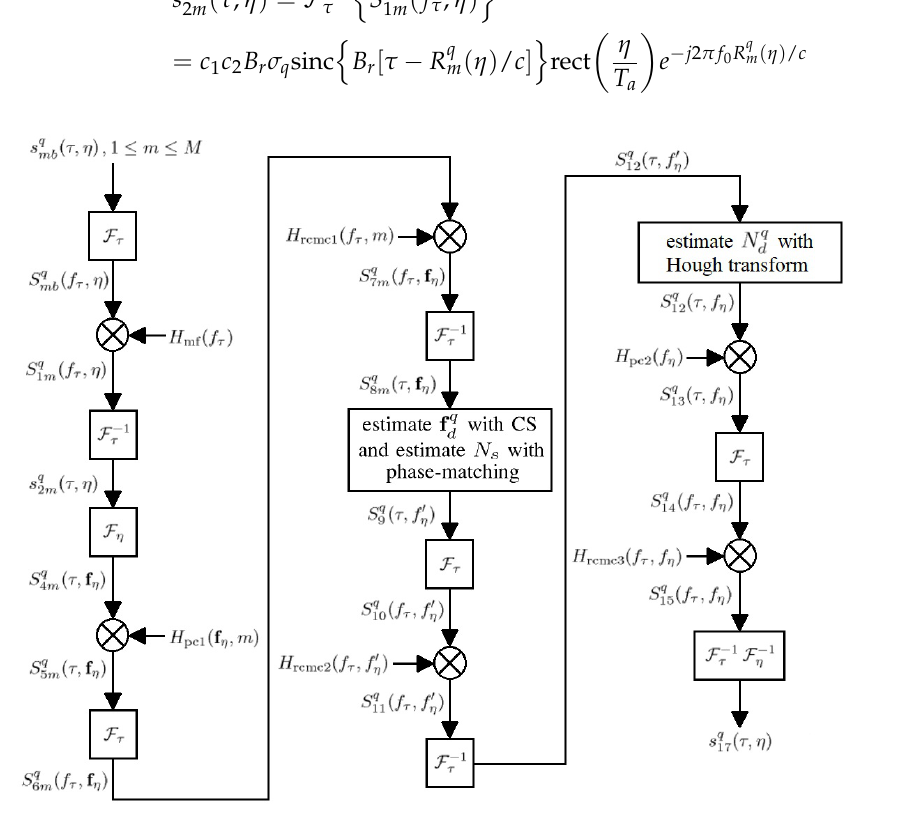
Figure 4. Flow-chart of multi-channel SAR imaging on sea-surface moving targets